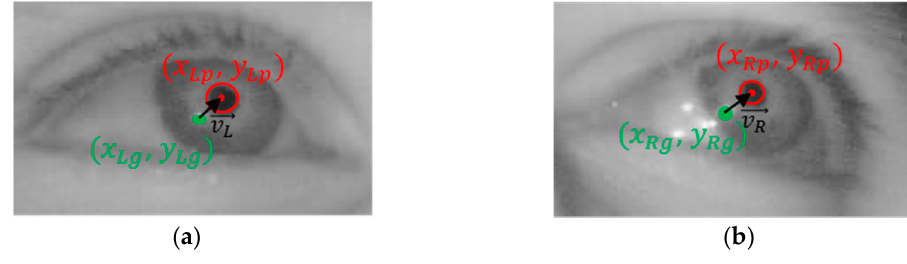
Figure 6. The PCCR vectors generated from ( a ) left eye and ( b ) right eye images.